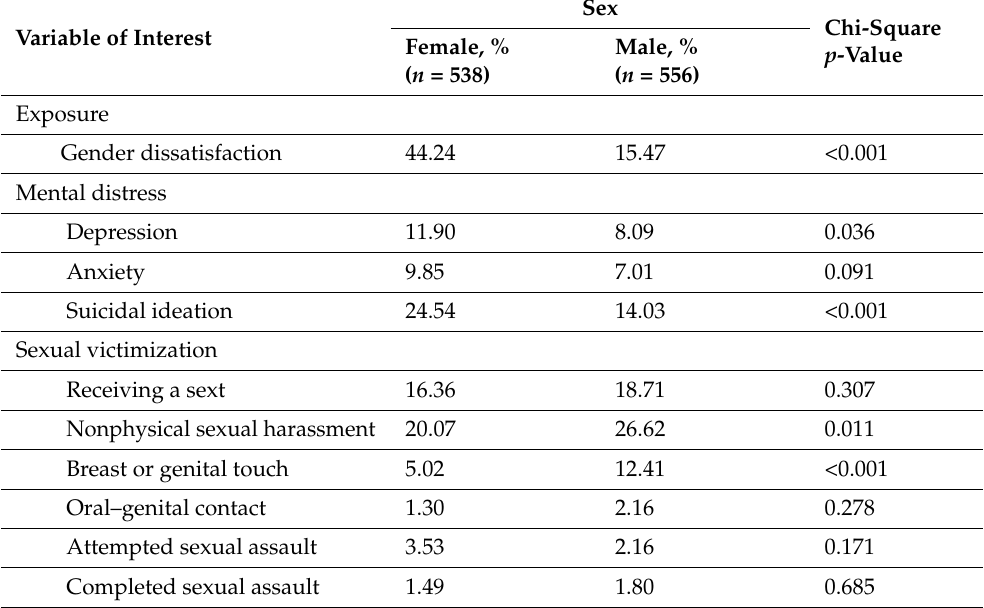
Table 3. The prevalence of gender dissatisfaction, mental distress, and sexual victimization by sex.